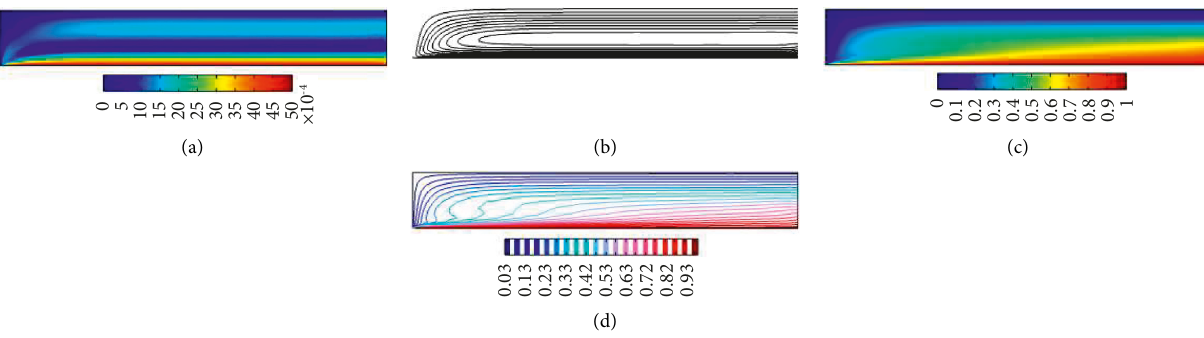
Figure 11: (a) Surface plot for velocity, (b) streamlines, (c) surface plot temperature, and (d) isothermal contours using Gr � 100 , β � 0 . 7 , Gr � 0 , U � 0 . 005. m w 0 1